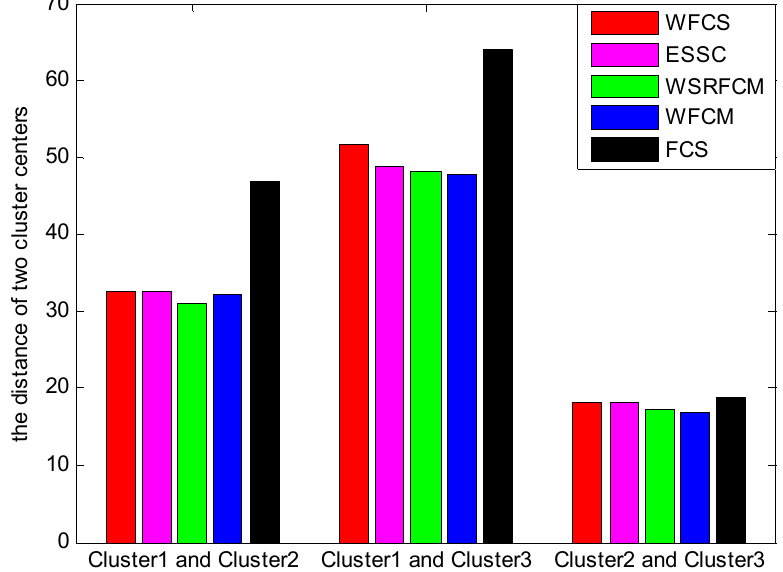
Figure 3. The distance between three cluster